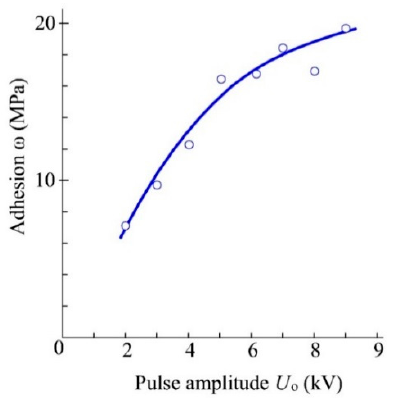
Figure 10. Dependence of the films adhesion ω on the amplitude of the applied voltage pulses to the